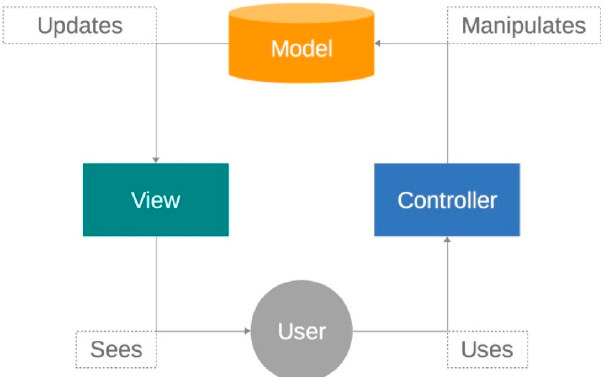
Figure 3. Collaboration between components in an MVC structure.